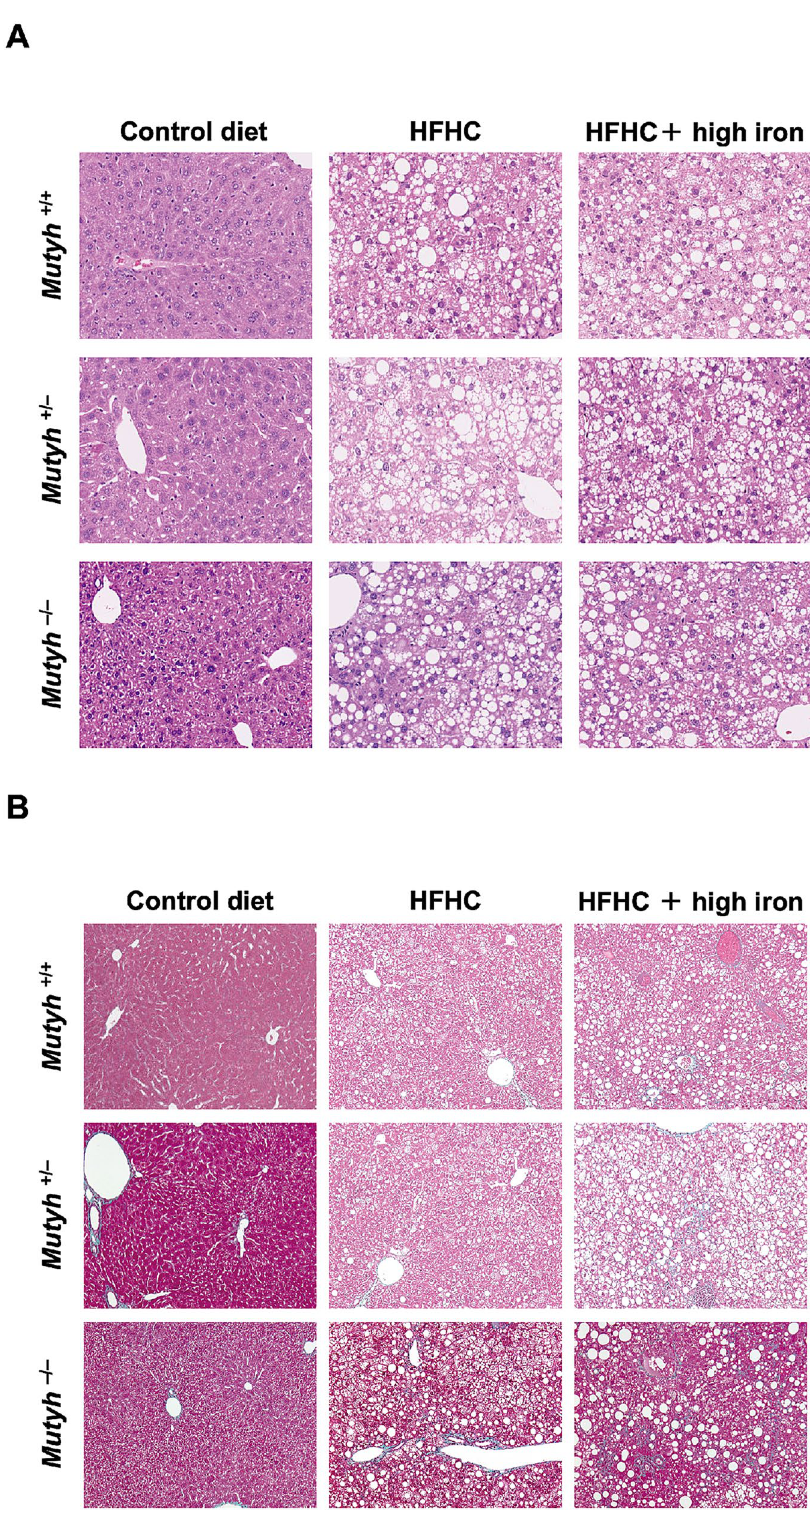
Figure 2. ( A ) Liver section (H&E × 100). In the groups fed an HFHC diet, prominent hepatic steatosis is seen associated with inflammatory infiltration and hepatocyte ballooning, regardless of a high-iron diet. No difference was seen between the genotypes. ( B ) Liver section (Masson trichrome stain × 100). In groups fed an HFHC diet, mild fibrosis was seen around the central veins, portal veins, and hepatocytes. HFHC, high-fat high- carbohydrate; H&E, hematoxylin &